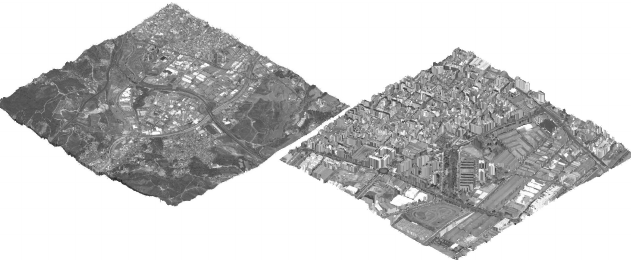
Figure 12: Overview on the Terrassa testsite, 3D views, left full 4 km × 4 km, right detail 1 km × 1